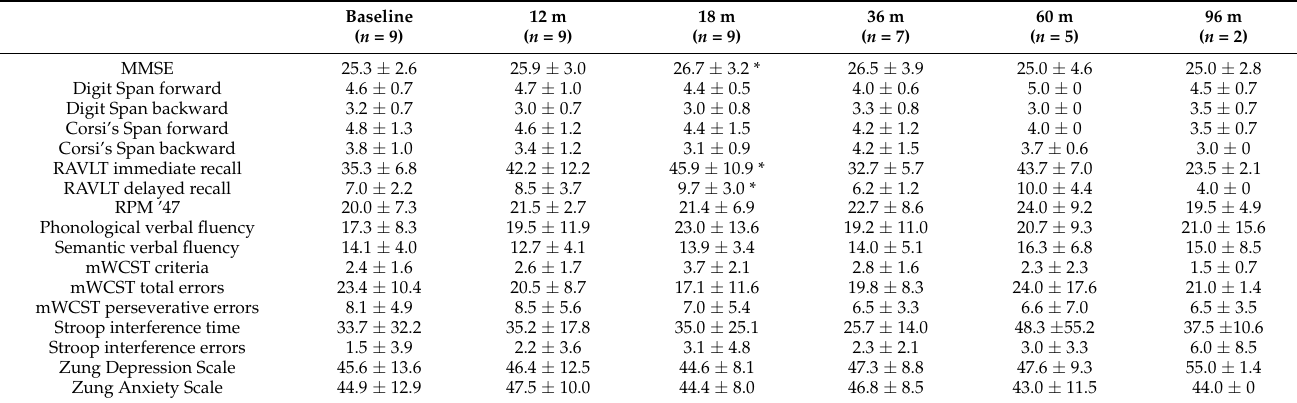
Table 3. Cognitive and behavioral evaluations in all patients, evaluated at different times after ECMS